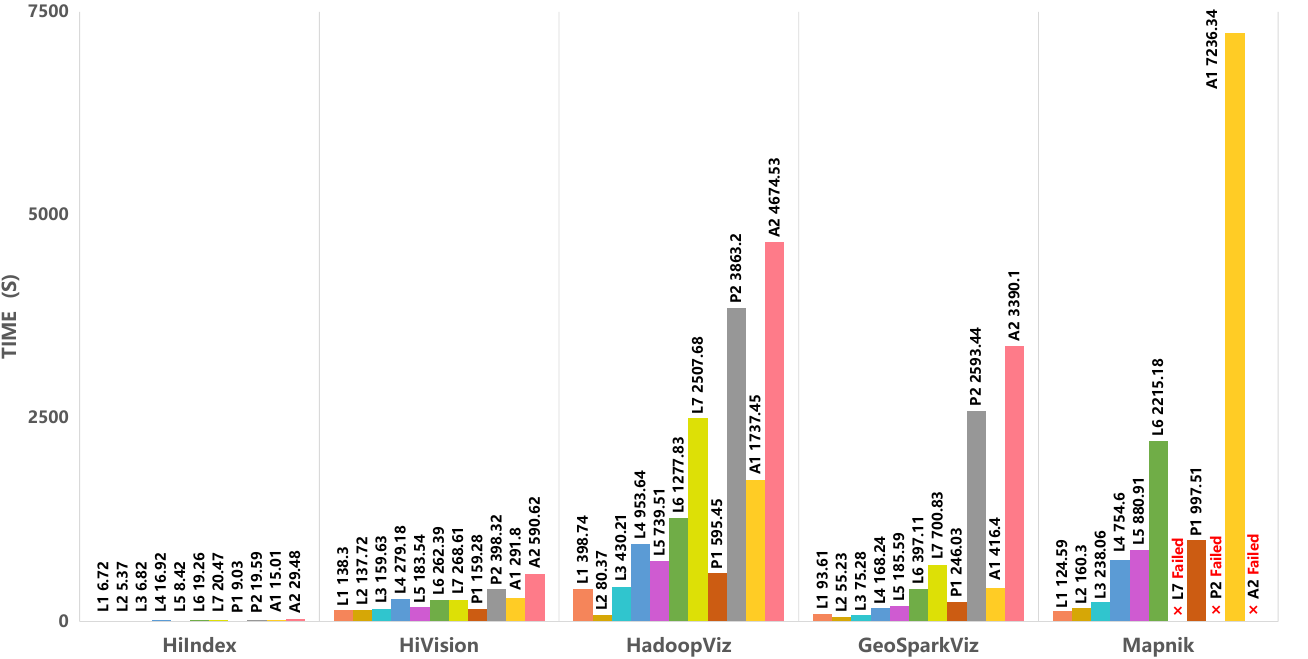
Figure 9. Total rendering time of generating all the tiles in zoom levels 1, 3, 5, 7, and